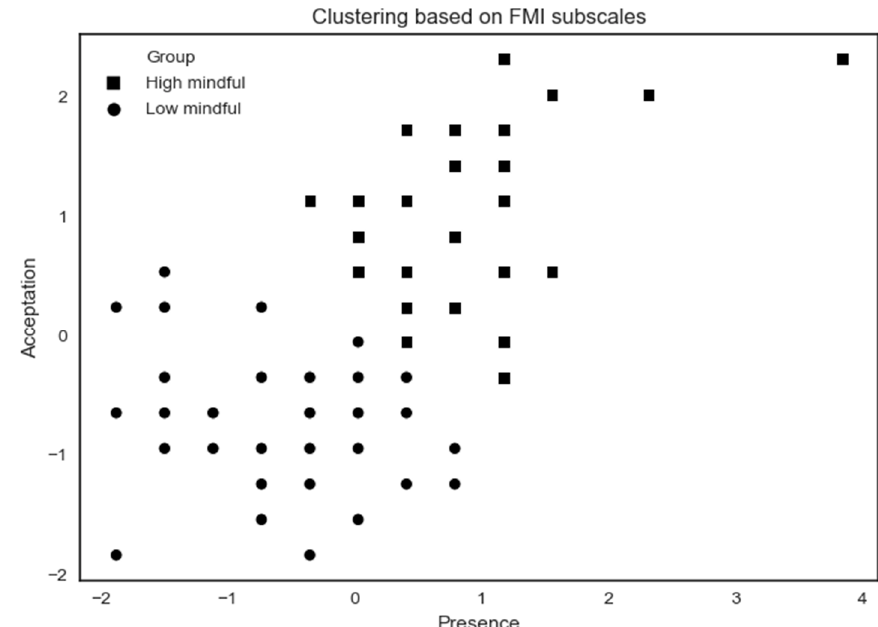
Figure 5. K-means clustering analysis applied on all subjects based on FMI subscales. Some participants share the same x- and y-coordinates causing them to merge at the same point. Table 2. Summary of MD profile on psychological assessments (mean ± standard